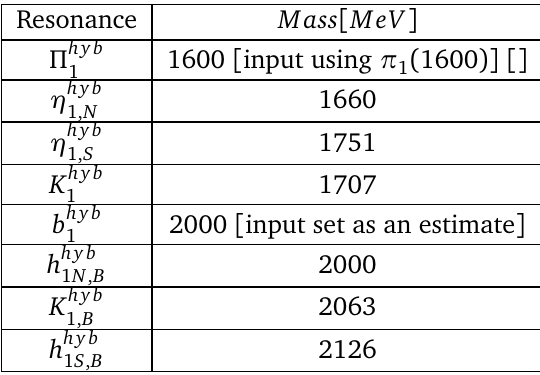
Table 1: Masses of the exotic J PC = 1 − + and J PC = 1 + − hybrid